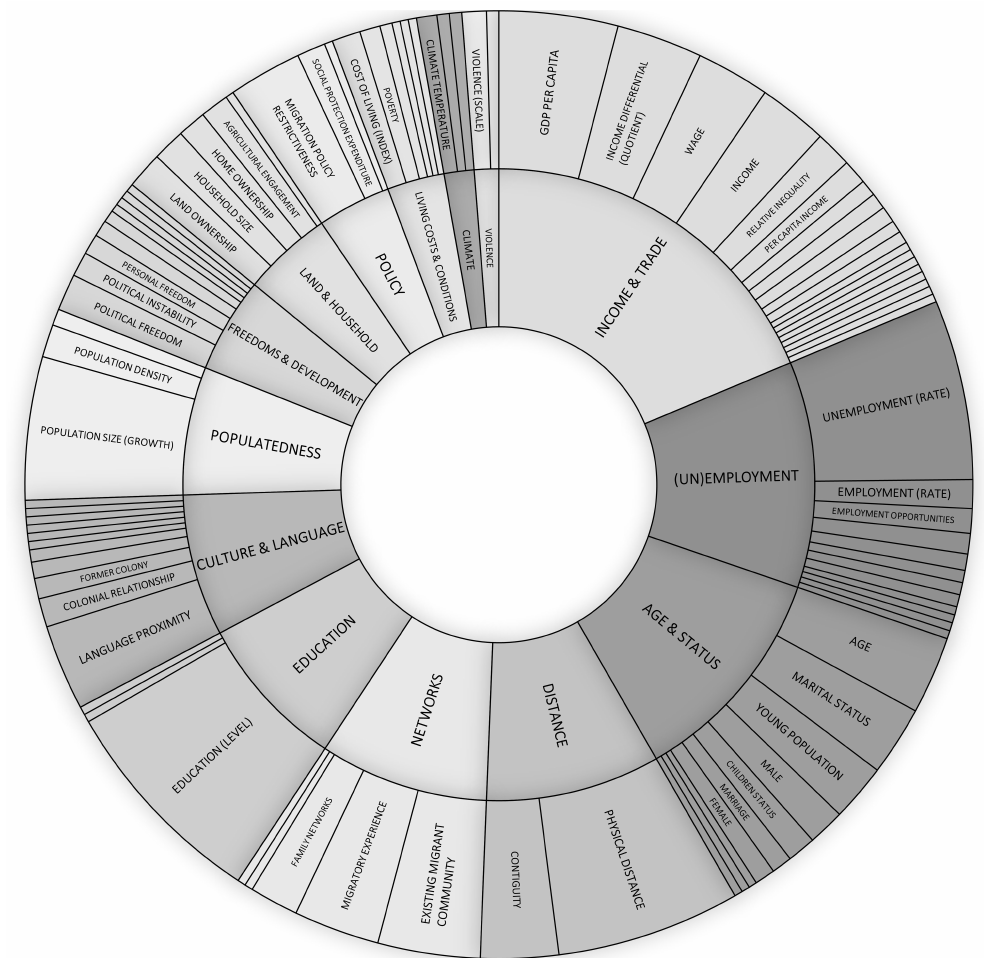
Figure 4. Top factors of migration, grouped (aggregated for the study